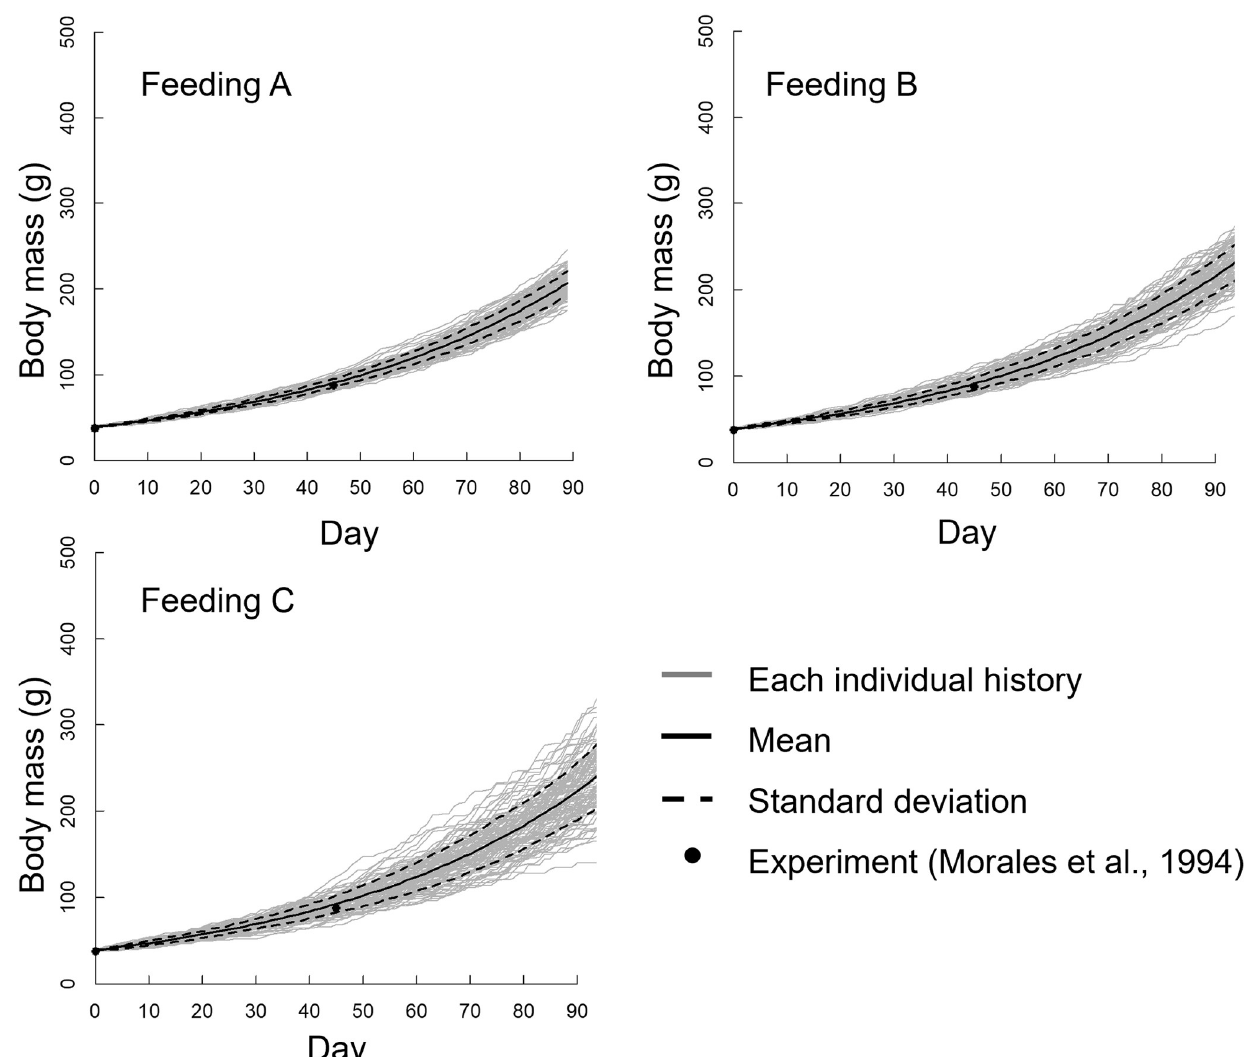
Fig 9. Growth history of the body mass of all 100 individuals using the three feeding methods, with randomization performed every day. The mean and standard deviation of the body mass and previous experimental results [19] are also indicated.